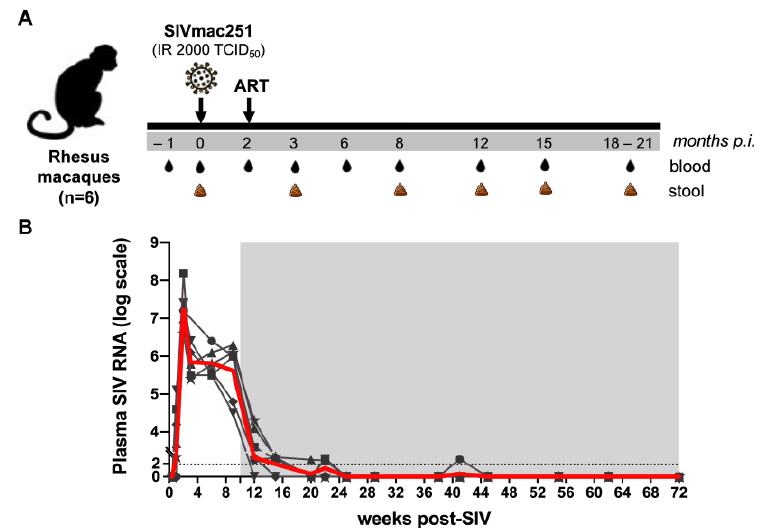
Figure 1. Study schedule and plasma viral loads. ( A ) Six animals were treated with a combination of ART drugs TDF, FTC, and DTG. Baseline samples were collected on d0 SIV, and ART was started 10 weeks following SIV infection. ( B ) Longitudinal SIV RNA quantification in plasma for 72 weeks of SIV-ART. The grey area represents ART. The red line is the average viral load for all animals. Early SIV infection resulted in a significant increase in plasma levels of multiple inflammatory cytokines and chemokines including IL-1 β , IL-18, IL-1R α , CXCL9/monokine induced by gamma (MIG), CXCL11/Interferon-inducible T cell alpha chemoattractant (I- TAC), macrophage inflammatory protein (MIP)-1 β , Granulocyte colony stimulating